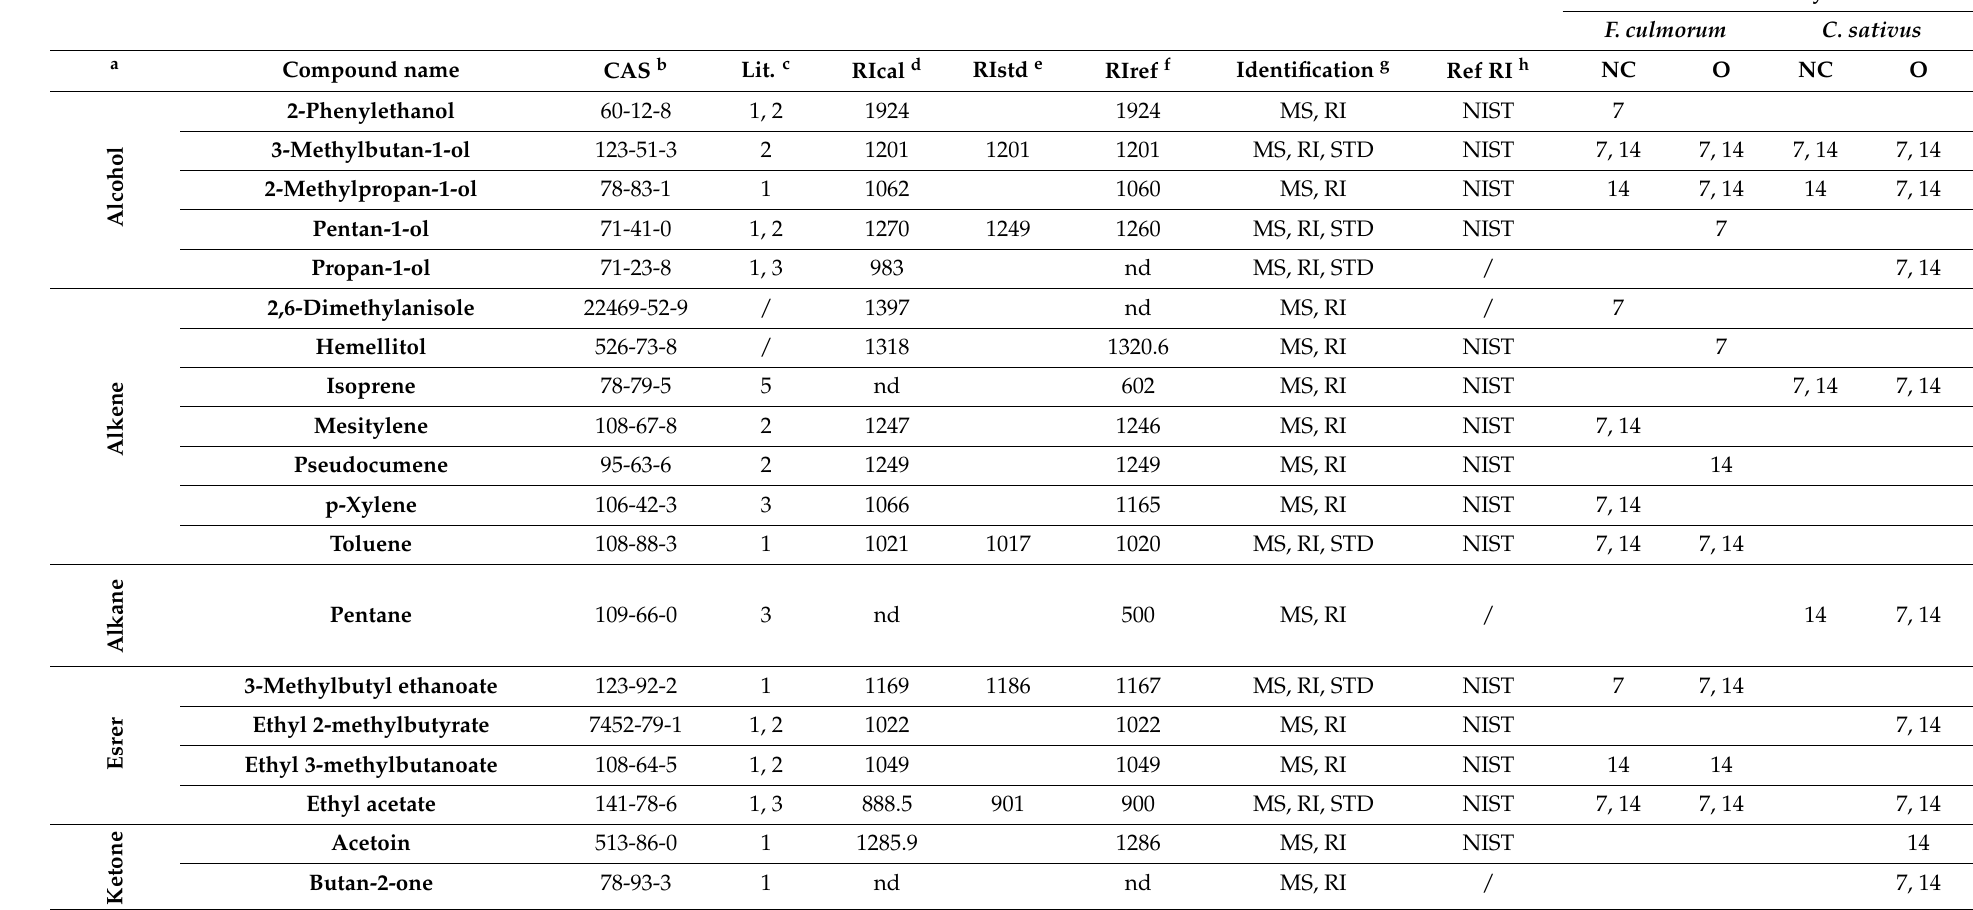
Table 2. VOCs emitted by F. culmorum and C. sativus